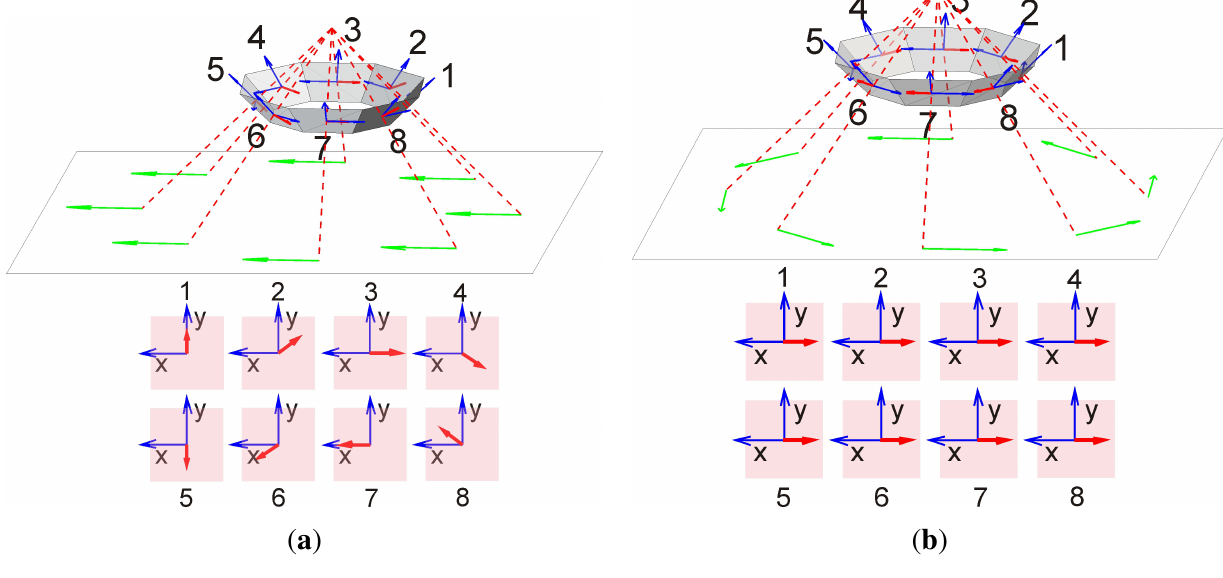
Figure 2. Sensor configuration and expected flow pattern. Each sensor marked with the sensor number has a viewing direction shown as a red dashed line and an image plane indicated by a gray transparent trapezoid. The directions of X - and Y -components in each image plane are indicated by blue arrows. The X direction is in all sensors nearly parallel to the horizontal plane. The red arrows show the optic flow induced in the sensors’ image planes by the ground velocity indicated by green arrows. The upper figures in ( a ) and ( b ) show a view onto the eight-sensors head from above and the side, the lower part shows the eight light sensitive areas and the corresponding optic flow. Figure 2a illustrates pure